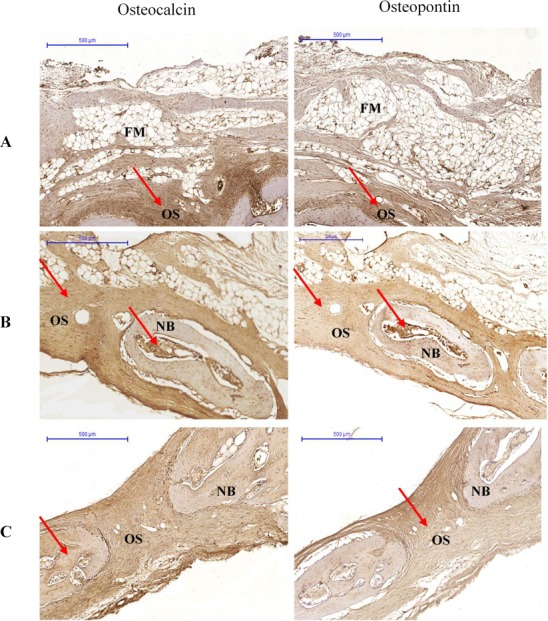
Photomicrographs of immunostaining for osteocalcin and osteopontin in (A) Group I, (B) Group II (C) Group III at 6 weeks.The pictures are arranged by staining technique (columns) and the investigated treatment (rows). Areas that stained positive for osteocalcin and osteopontin are indicated by red arrowheads. NB, new bone; OS, osteoid; FM, fatty marrow.